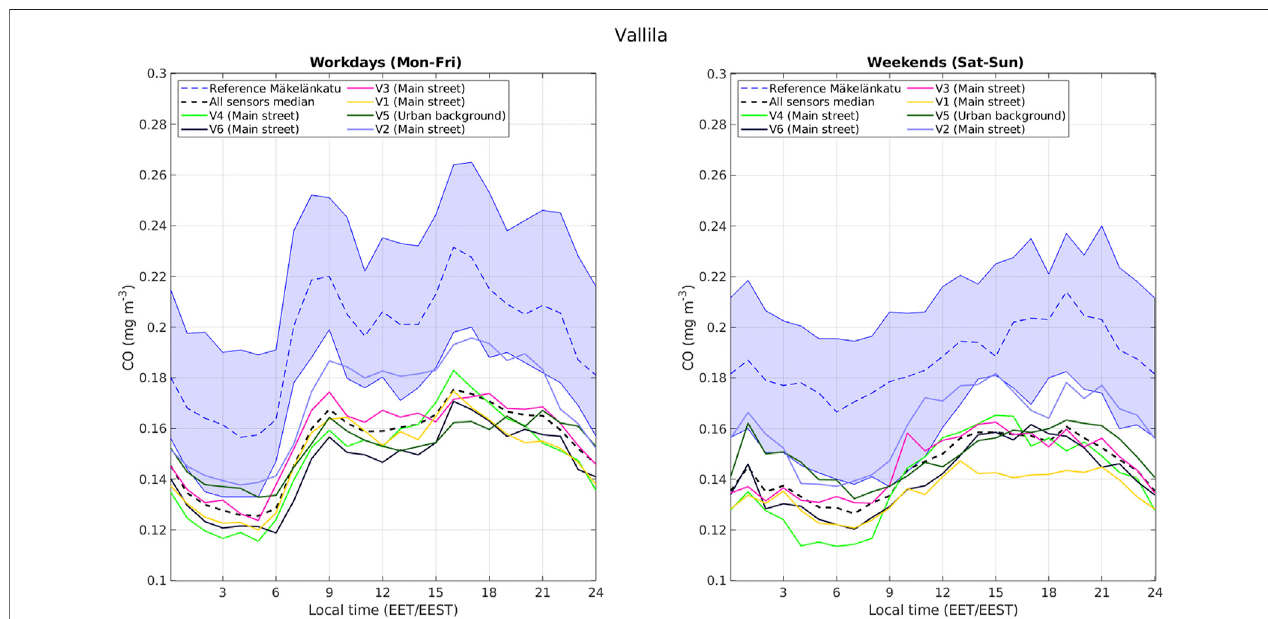
FIGURE 5 | Median CO diurnal cycles during 5-month period (1.8.-31.12.2020) for sensors located in Vallila (left) workdays (Mon-Fri) and (right) weekends (Sat- Sun). Reference measurements show median (dashed line) and 25th and 75th percentiles (shaded area) from nearest reference instruments. Black dashed line shows median diurnal cycle calculated for all data from that location.